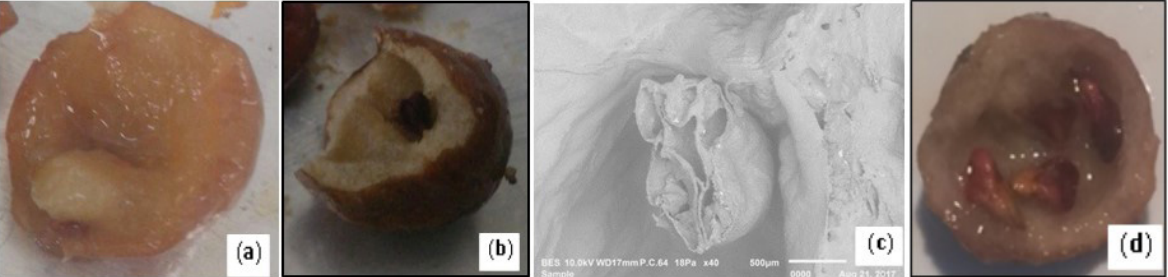
Figure 3. Grape sectional view: (a) fresh, (b)as freeze-dried, (c) as freeze-dried in SEM and (d)